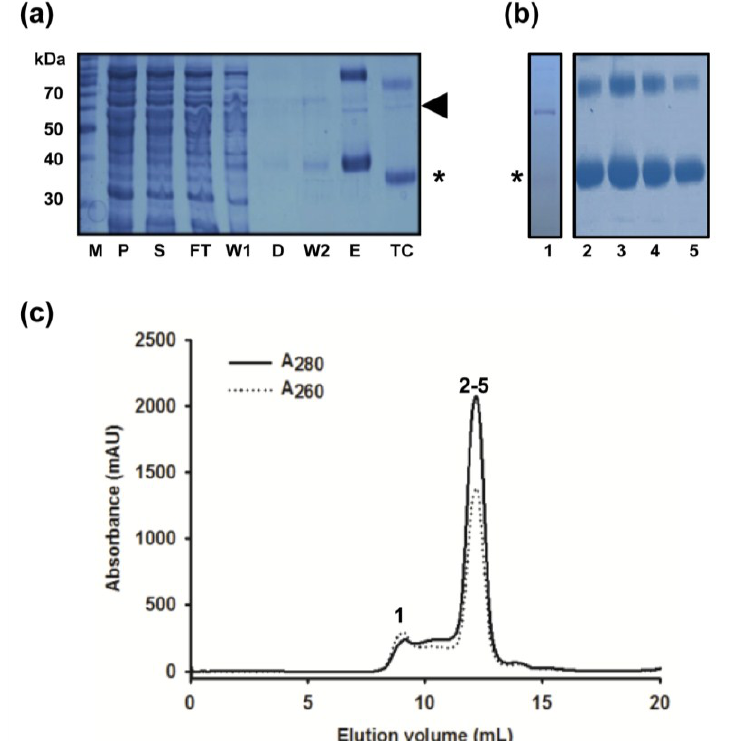
Figure 2. Purification of MdtM using the modified protocol. ( a ) Coomassie stained SDS-PAGE of protein fractions from Ni-NTA chromatography that included an incubation step with ATP to remove chaperonin contamination. Samples were incubated in SDS-PAGE sample loading buffer for 10 min at room temperature prior to loading onto the gel. Gel lanes were loaded with molecular weight marker protein marker (M), membrane pellet fraction (P), DDM-soluble fraction (S), column flow through (FT), wash one (W1), eluate from the ATP dissociation step (D), wash two (W2), 250 mM imidazole elution fraction (E), and the thrombin-cleaved fraction (TC). MdtM is denoted with (*) and chaperonin contaminant is marked with an arrow; ( b ) Coomassie stained SDS-PAGE of peak fractions from MdtM purification using FPLC size exclusion chromatography in 0.25 mM DDM. Lane 1, sample from the ~9 mL elution peak; lanes 2–5, samples from across the ~12 mL major elution peak. Lanes 2–5 were overloaded with sample to illustrate the absence of detectable 58 kDa contaminant; ( c ) SEC chromatogram of MdtM after removal of chaperonin. The protein absorbance at 280 nm and 260 nm is represented by solid and dashed lines, respectively. Numerals above the absorbance peaks correspond to the gel lanes in panel ( b